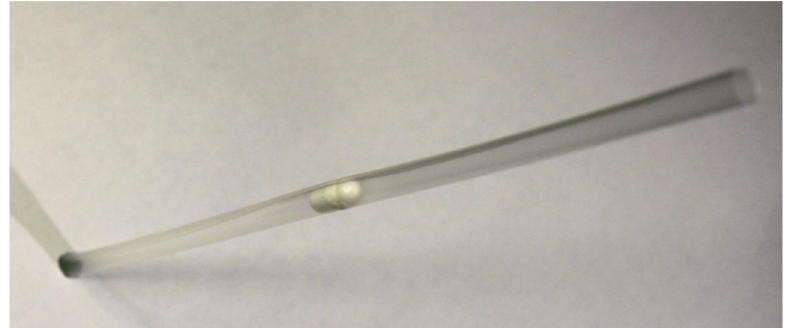
Figure 6. An illustration of a bulge formed on an S2 straw with its diameter reduced below the external diameter of a capsule #5 (for the sake of illustration a white coloured one is used). The S2 straw bulges easily due to the incision running along its length. The same incision allows to effortlessly adjust the position of the capsule, whereas the clamping force of the walls of the straw assures its alignment even during the reciprocal space option oscillatory movement in the sample chamber.